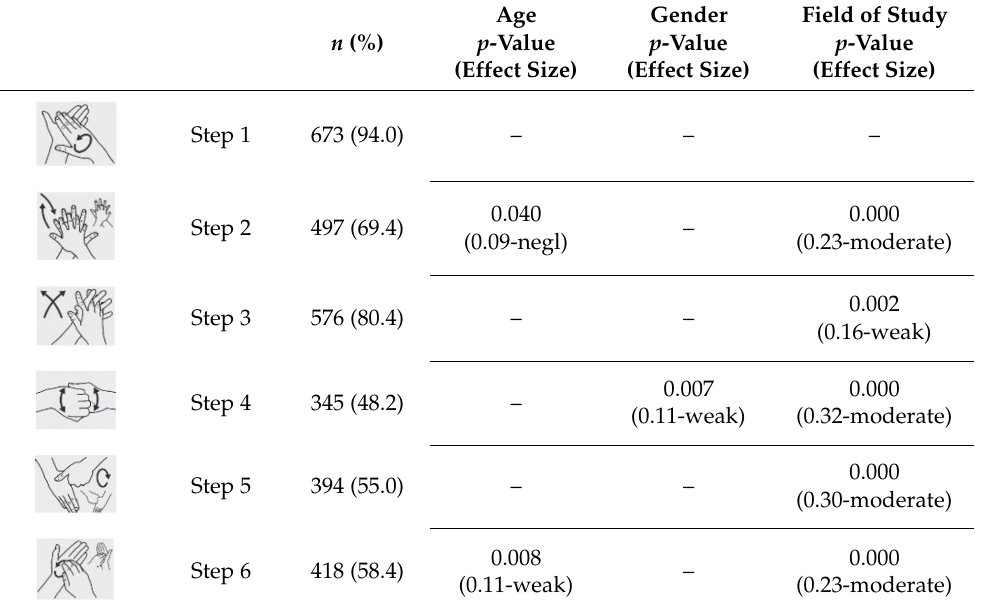
Table 7. Steps applied (self-reported) in hand hygiene.